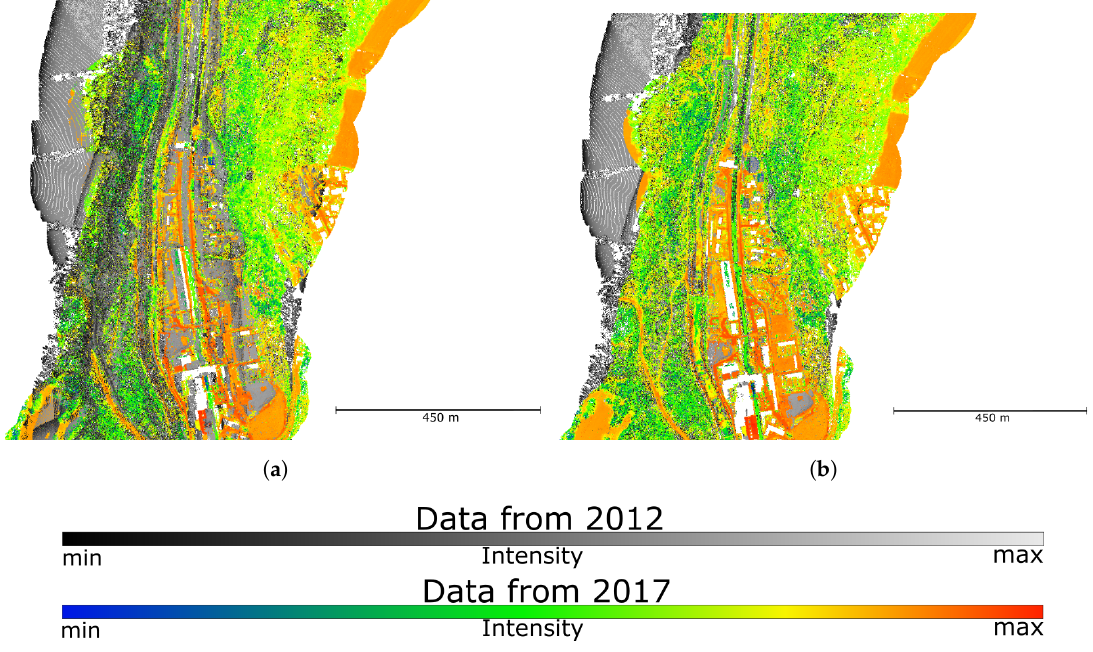
Figure 9. Comparison of the registration results using ICP and the proposed approach shown on the whole flight strip. ( a ) Result of ICP. ( b ) Result of the proposed method. Shown data are the date of the whole flight strip downsampled to 1 m